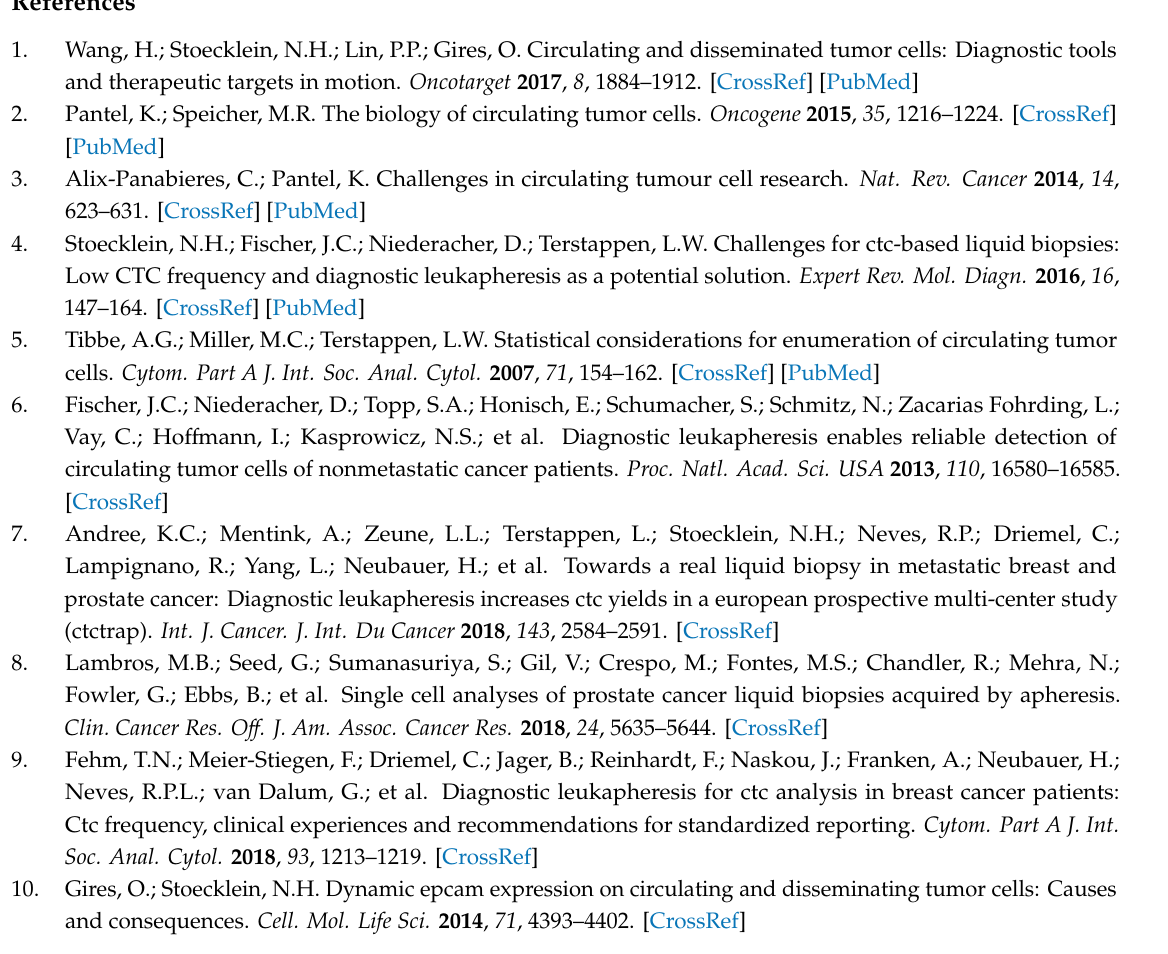
Table S1: Di ff erent amounts of Thermo Fisher beads used for enrichment in the KingFisher system, Figure S1: Estimation of the size of Iso-CEK and Iso-RCEK beads, Figure S2: Determination of the concentration of the Iso-CEK beads, Figure S3: Plate setup and protocols used for enrichment of CTCs in the KingFisher instrument, Figure S4: Recovery of CAPAN-1 and HuP-T4 using the CellSearch system, Figure S5: Recovery of HuP-T4 and CAPAN-1 with four di ff erent types of beads, Figure S6: E ff ect of cell preservative in the recovery of CAPAN-1 cells, Figure S7: Recovery of CAPAN-1 cells spiked in whole blood samples, and recovery of colon and breast cancer cell lines spiked in mimicked-DLA products, Figure S8: Determination of the number of white blood cells co-enriched in KingFisher system using BioBMAX-VU1D9 beads, Figure S9: EpCAM-based enrichment after depletion of CD45pos cells, Figure S10: Capturing of staining antibodies by the